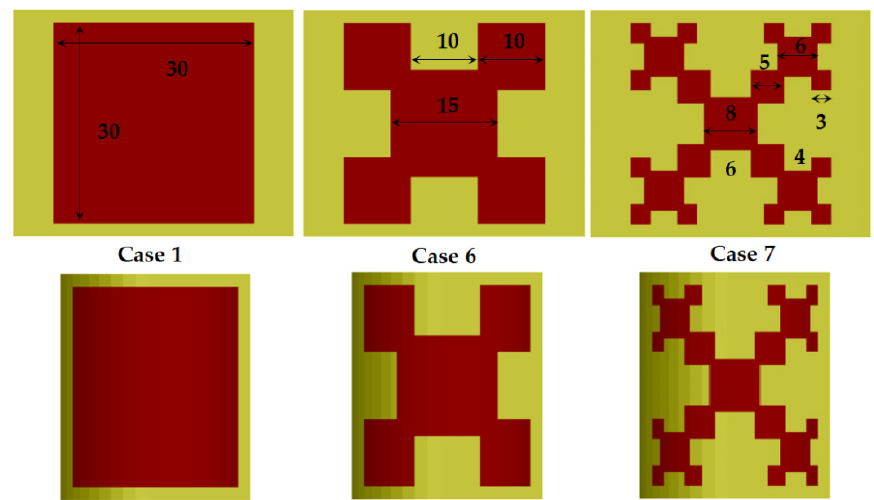
Figure 17. Simulated values of the ratio f aniso / f iso between the resonance frequencies of the lowest- order mode in several planar resonance structures with dimensions 30 × 30 mm on anisotropic and isotropic substrates ( h s = 0.52; Δ A ε ~ 25%) (this ratio gives the pure effect of anisotropy). The shapes of the considered structures are presented in Figures 19 and 20. The first column for each case cor- responds to a flat structure, second—bent at α C = 8°; third—bent at α C = 12°; Solid and hollow points correspond to two mutually perpendicular orientations (V & H) of the structure during the bending (when this is possible).